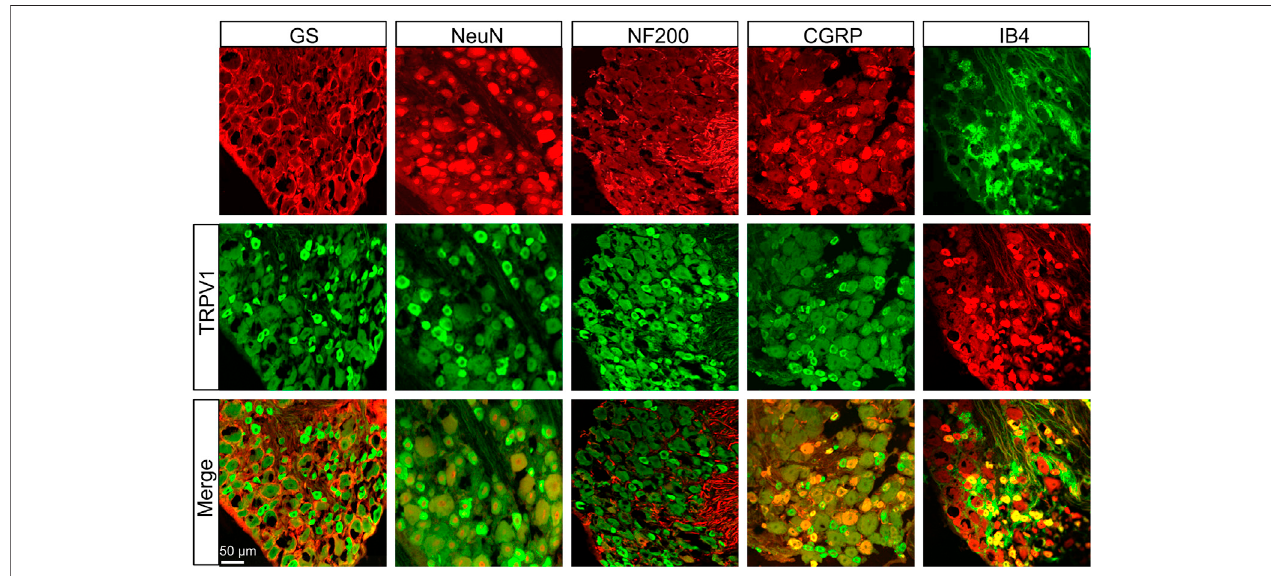
FIGURE2| Immuno fl uorescenceassayofTRPV1inL4-6DRGs.TRPV1-positiveDRGcells(middlerow)wereco-labeledasneuron-positive(upperleftsecond,red)butnot with GS-positive cells (upper left fi rst, red). TRPV1 was co-expressed in IB4-positive (upper right fi rst, green) and CGRP-positive (upper right second, red) DRG neurons. TRPV1 was a few expressed in NF-200-positive (upper middle, red) DRG neurons. Merges of TRPV1 with GS, NeuN, CGRP, NF-200, and IB4 are shown in the lower row. Scale bar, 50 μ m. Quanti fi cation showing that TRPV1 was mainly located in small and medium sensory neurons labeled with IB4 and CGRP but a few with NF-200.